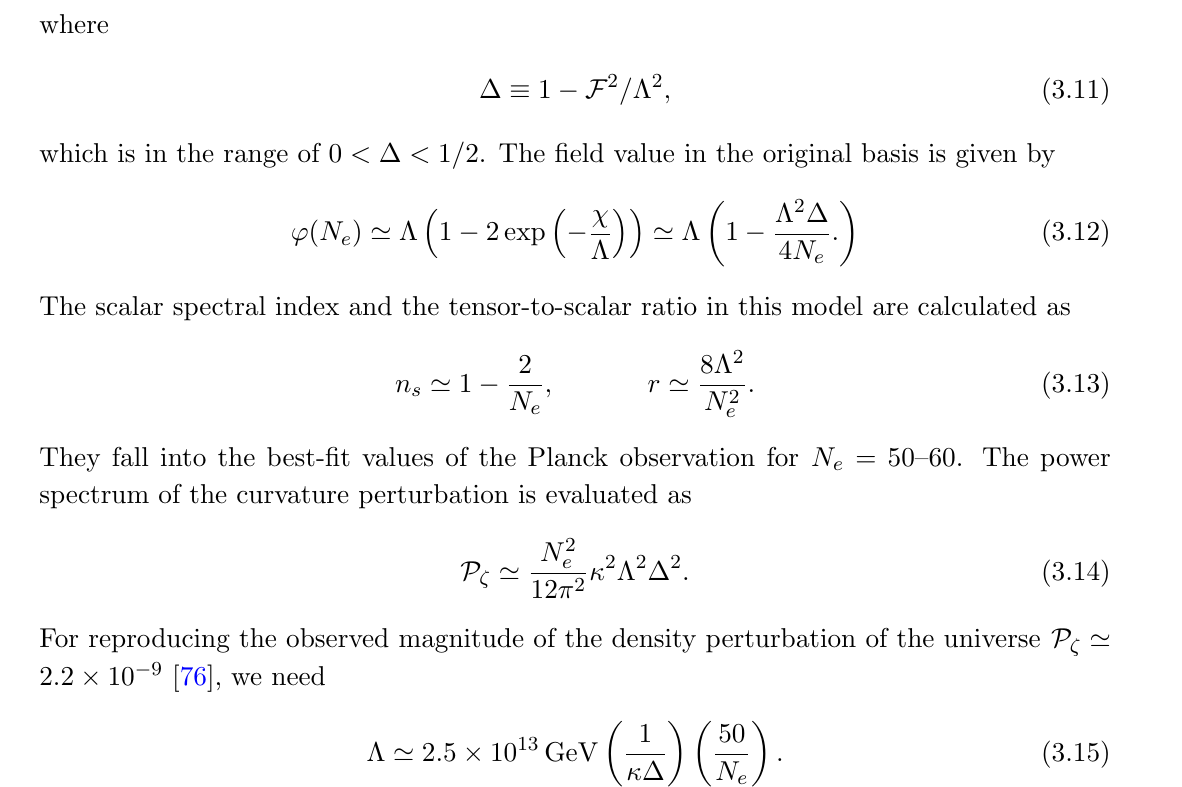
Figure 2 . The in(cid:13)aton potential in terms of the canonical (cid:12)elds ’ c and ’ F = (cid:3) = 0 : 75 and (cid:3) 2 = 0 : 1 (left) and (cid:3) 2 = 0 : 2